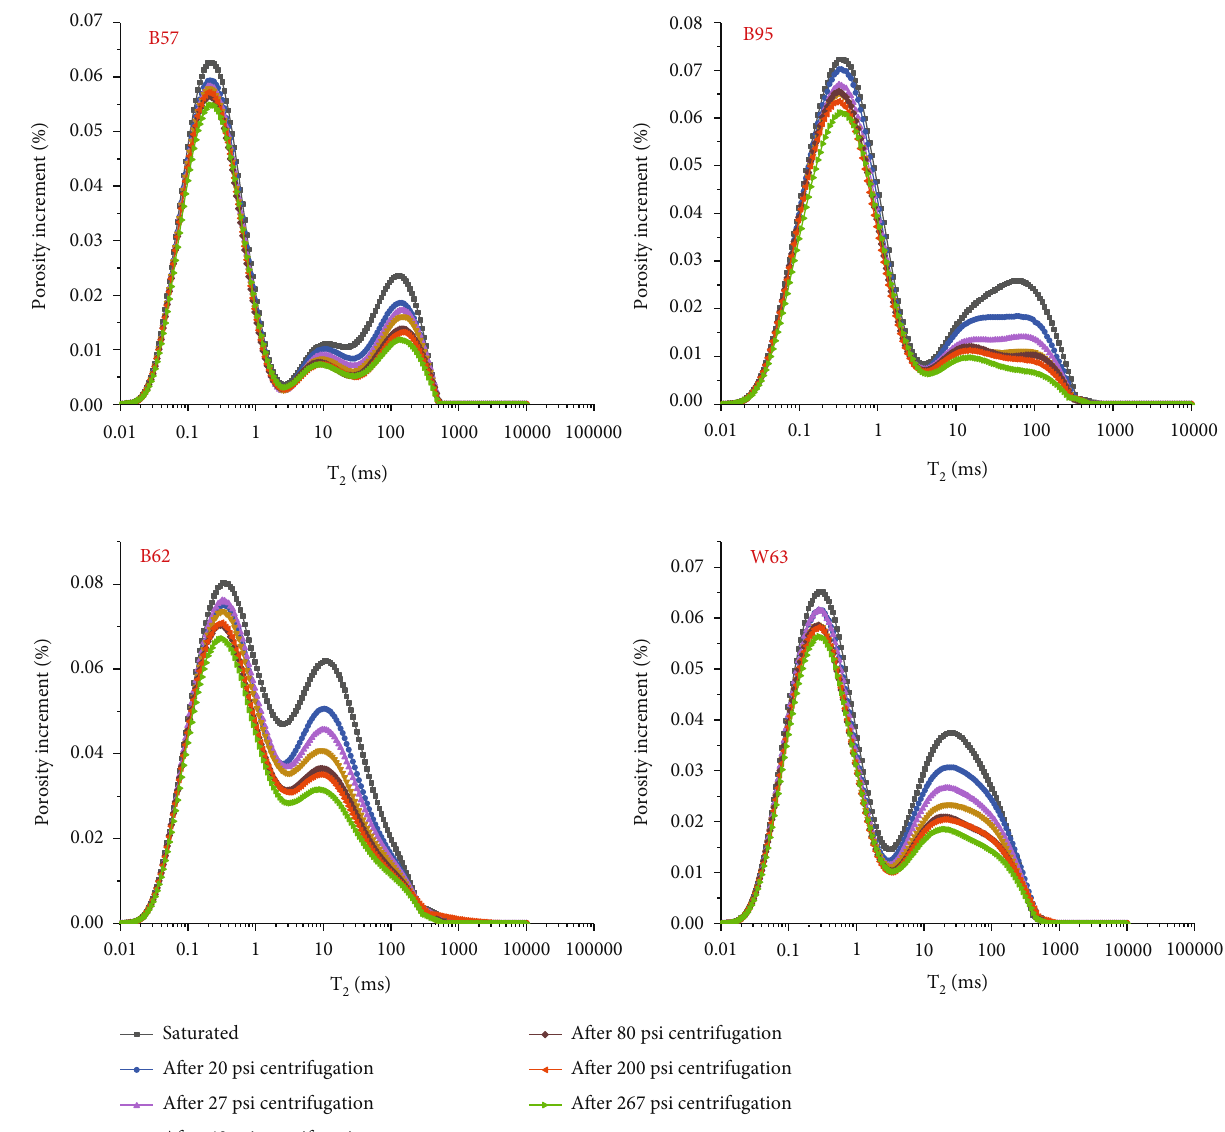
Figure 7: Characteristics of NMR T